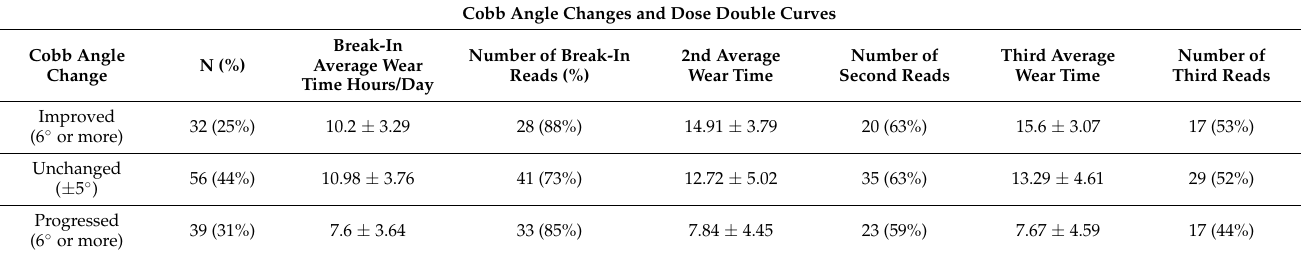
Table 4. Cobb angle changes and doses for double curves.